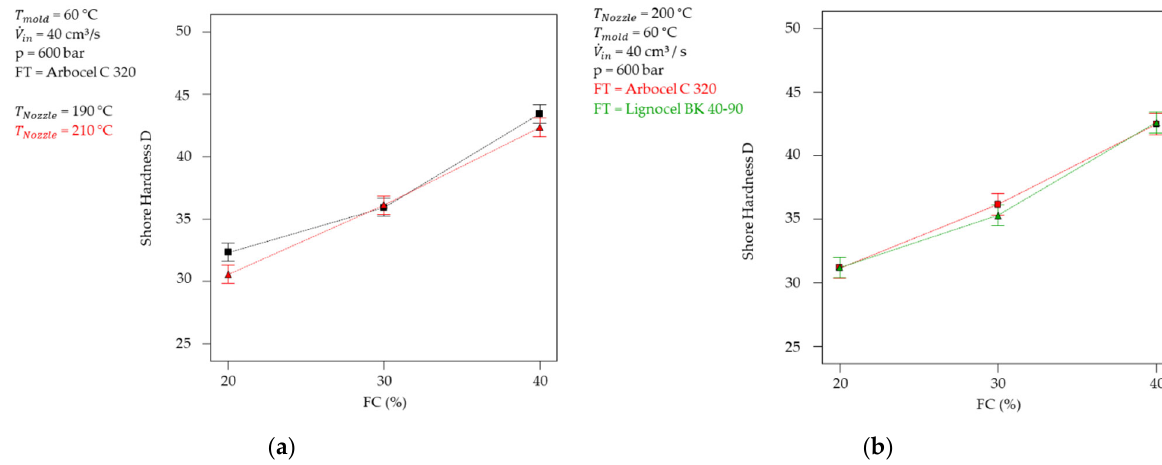
Figure 8. ( a ) Shore Hardness D of wood-filled TPU in dependence of temperature control. ( b ) Shore Hardness D of wood-filled TPU as a function of fiber content and fiber type. Table 5. p ‐ values of various test parameters for Shore hardness.